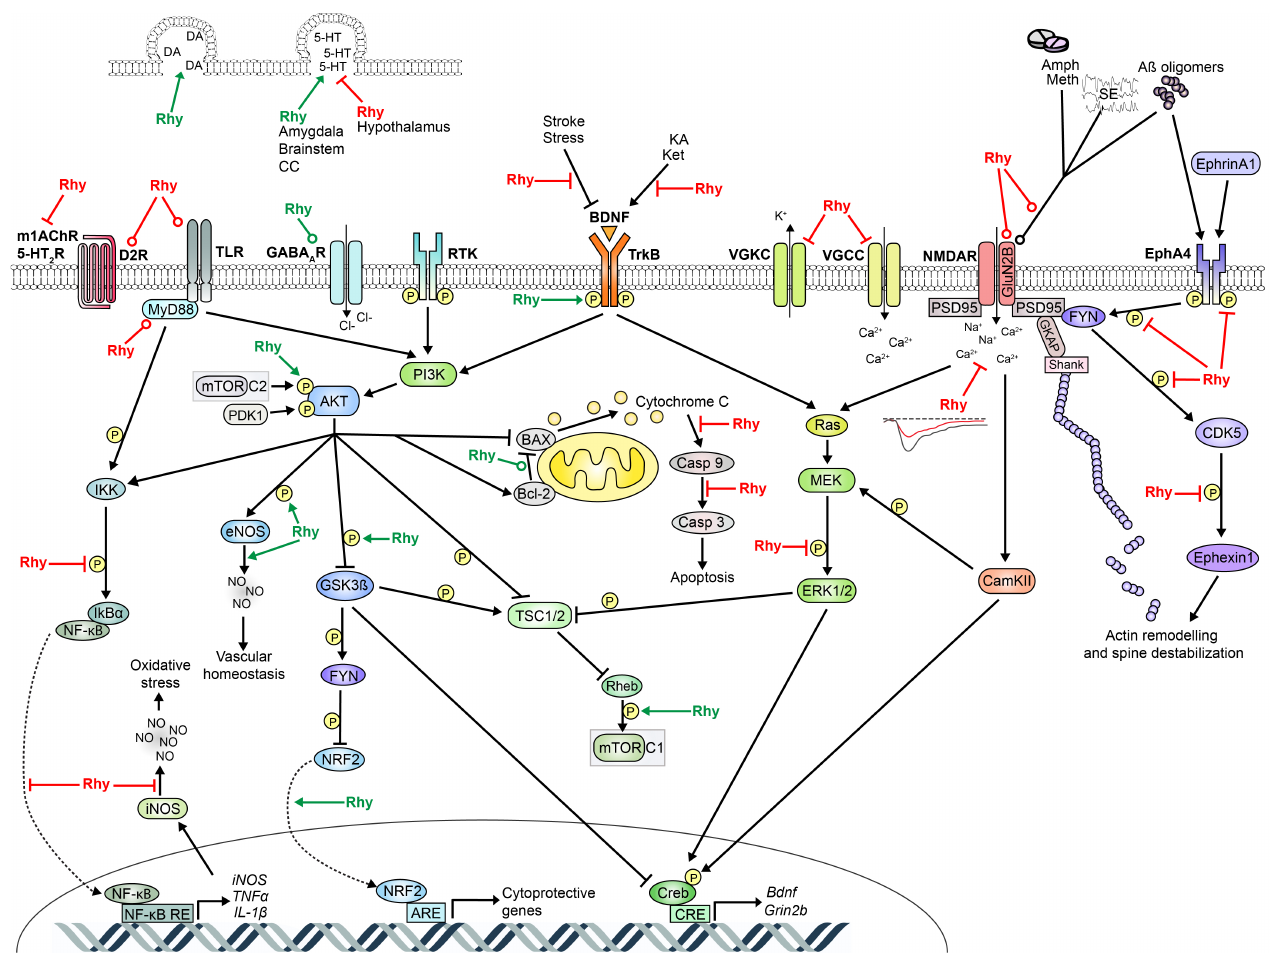
Figure 2. Schematic representation of cellular pathways targeted by Rhy and relevant to sleep regulation. Red flat-head lines: Rhy inhibition; Green arrows: Rhy induction; Red round-head lines: Rhy-dependent decrease in expression level; Green round-head lines: Rhy-dependent increase in expression level. Additional interactions between these cellular pathways are not represented but could also be relevant to sleep molecular physiology. For instance, L-VGCC can activate ERK/MAPK [144] and are suggested to induce CaMKII, NR2B phosphorylation, and CREB activation [106,145]. NMDARs may also activate the PI3K/AKT pathway [143]. In addition, NF- κ B and ERK/MAPK pathways were shown to interact with each other [82,142]. 5-HT: 5-hydroxytryptamine or serotonin; 5-HT2R: serotonin receptor 2; A β : amyloid β ; Amph: amphetamine; AKT: RAC serine/threonine-protein kinase; ARE: antioxidant response element; BAX: Bcl-2 associated X protein; BDNF: brain-derived neurotrophic factor; CamKII: Ca 2+ /calmodulin-dependent protein kinase; Casp 3: caspase